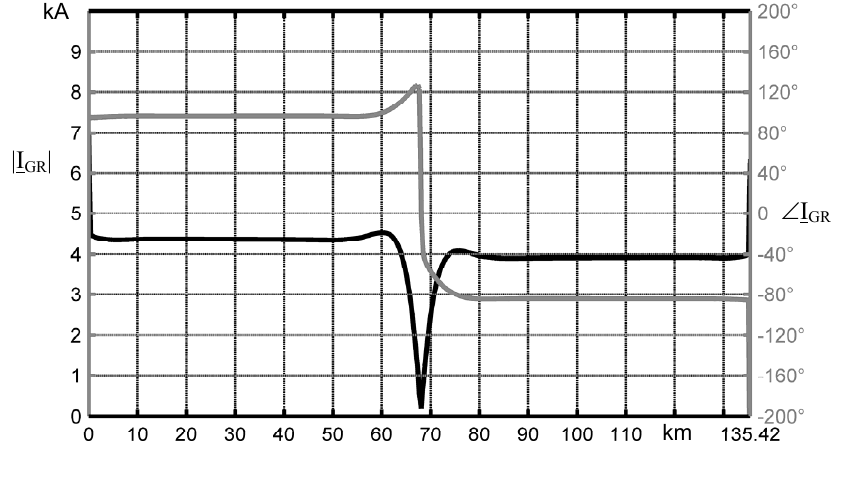
| and angle along the line in fault GR